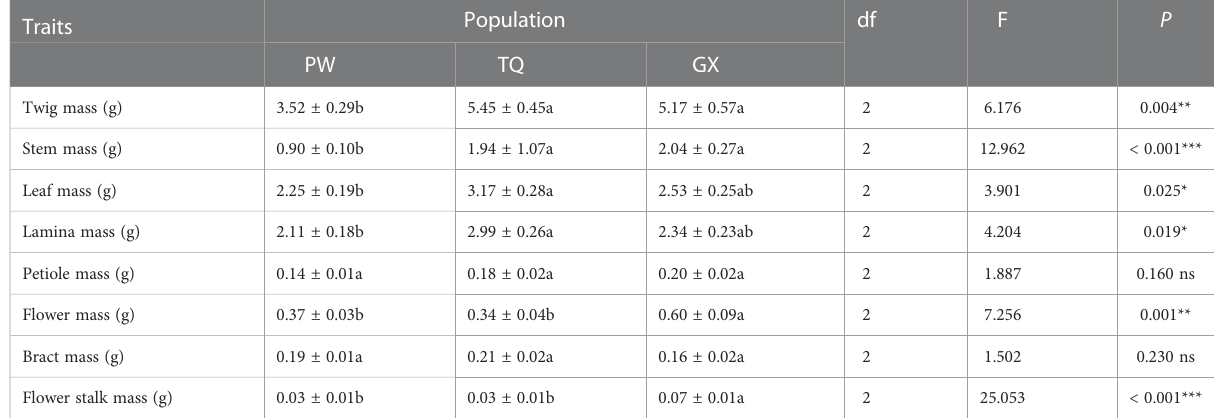
TABLE 3 The biomass traits of annul D . involucrata twig in three latitude regions (mean ± SE ). Traits